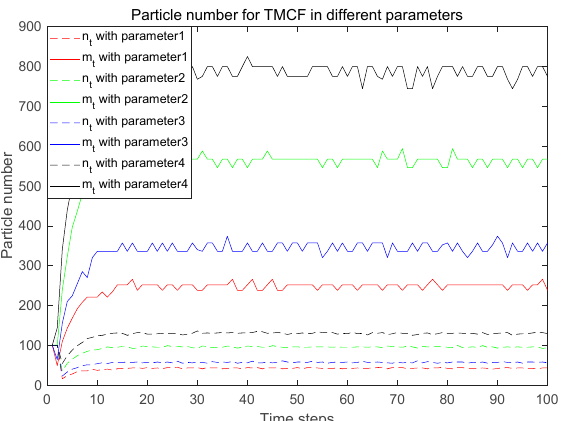
Figure 11. Number of particles required for the TMCF algorithm with different parameters.